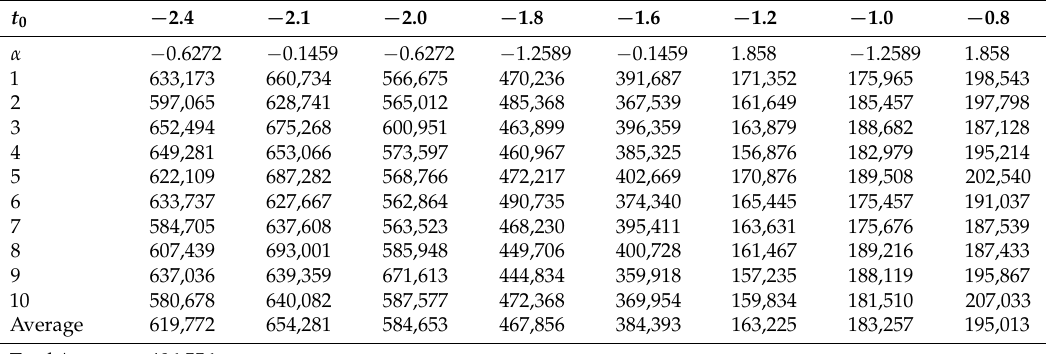
Table 5. Running time for different initial values of Example 2 by the algorithm